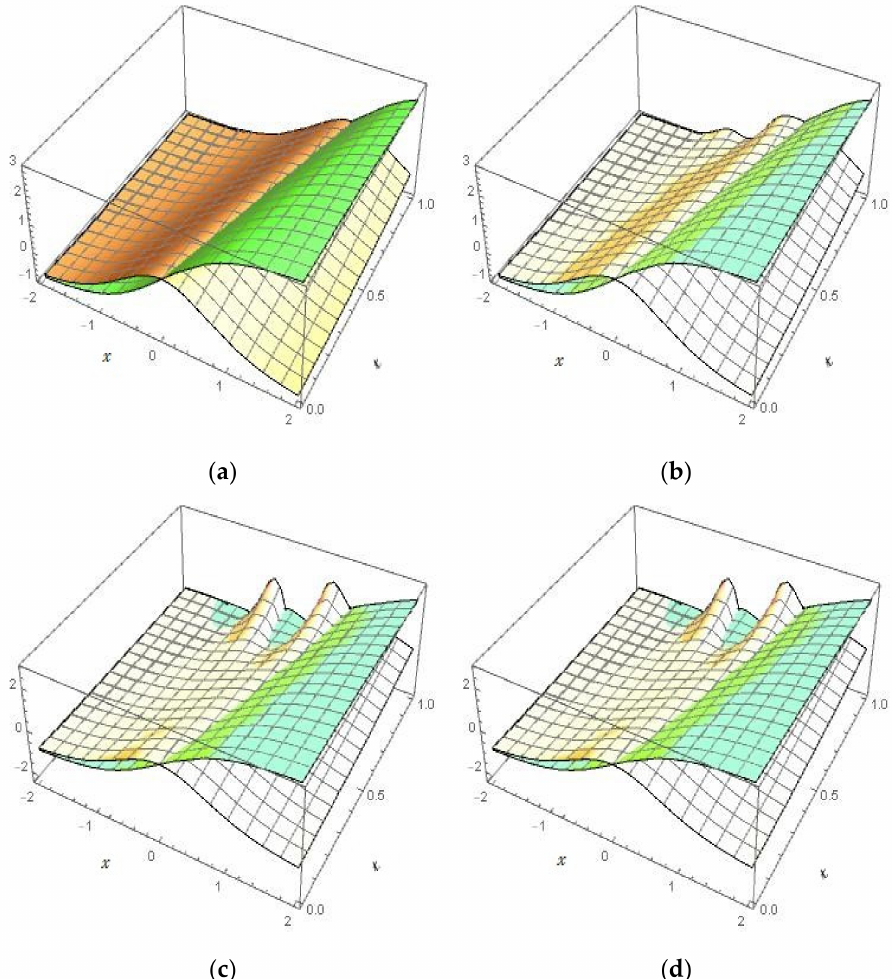
Figure 1. 3D-Surfaces plot of the exact solution of U ( 𝓍 , 𝓉 ) and V ( 𝓍 , 𝓉 ) , and the 7 − th approximate solution U 7 ( 𝓍 , 𝓉 ) and V 7 ( 𝓍 , 𝓉 ) , for IVP (7), with 𝓉 ∈ [ 0,1 ] , and 𝓍 ∈ [ − 2,2 ] , at various values of 𝒶 . ( a ) ( U ( 𝓍 , 𝓉 ) , V ( 𝓍 , 𝓉 )) . ( b ) ( U 7 ( 𝓍 , 𝓉 ) , V 7 ( 𝓍 , 𝓉 )) : 𝒶 = 1. ( c ) ( U 7 ( 𝓍 , 𝓉 ) , V 7 ( 𝓍 , 𝓉 )) : 𝒶 = 0.97.